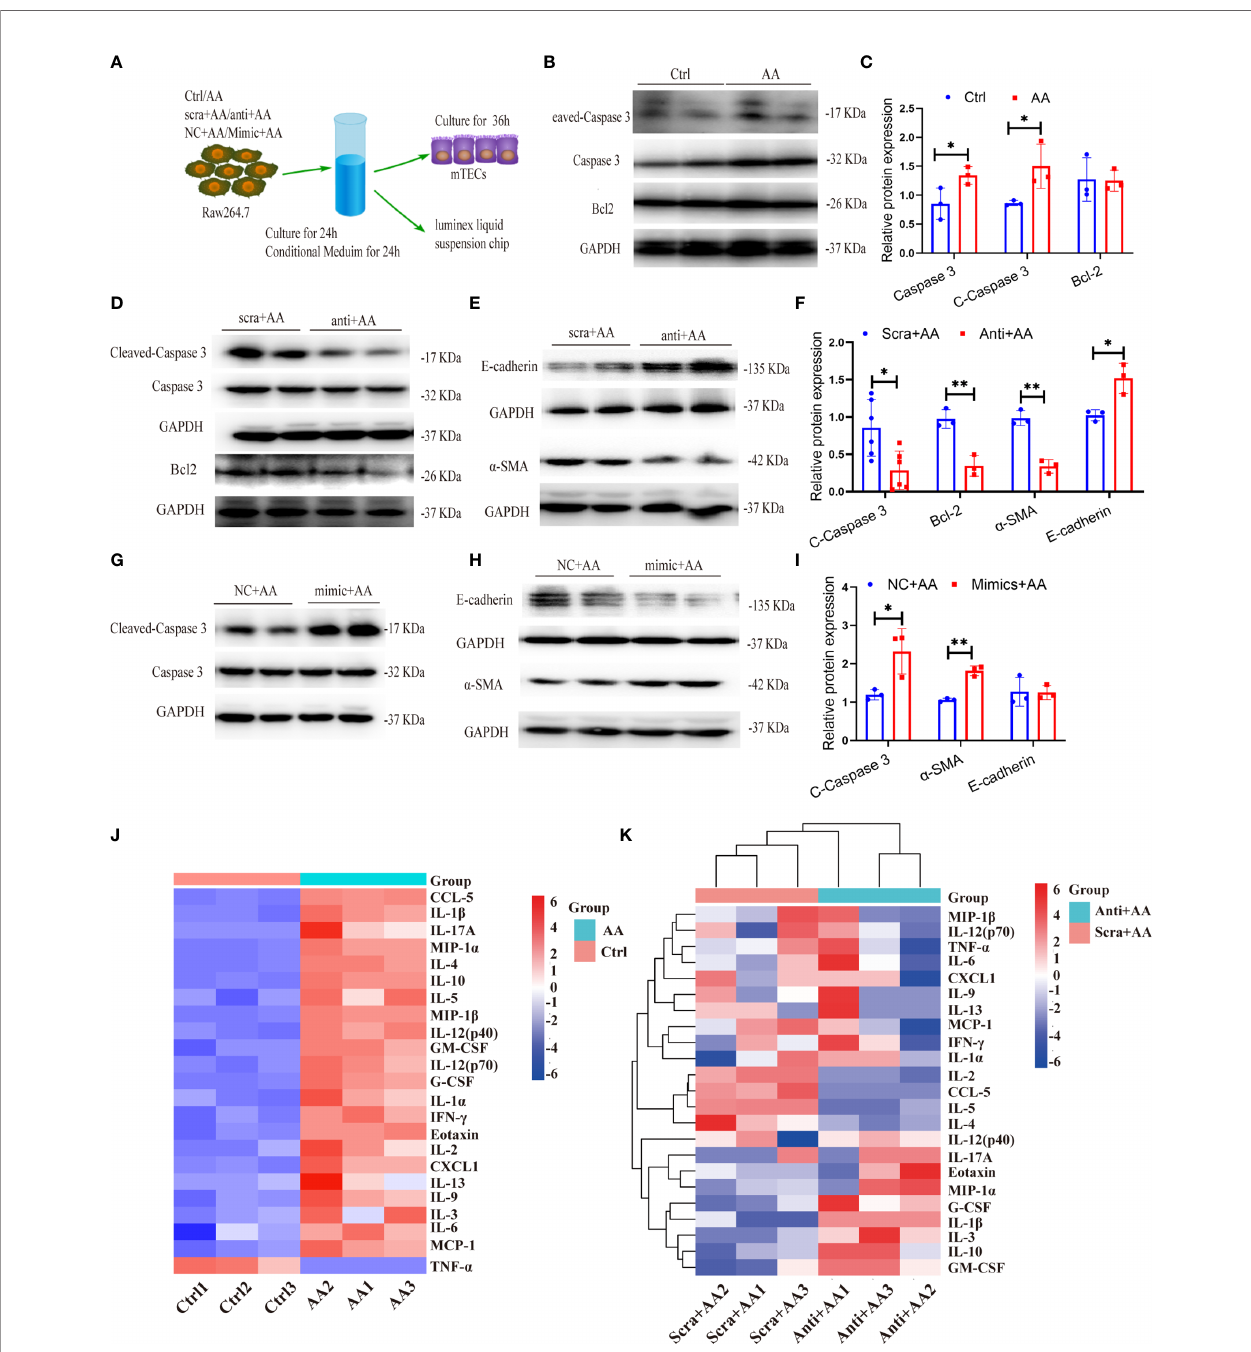
FIGURE 10 | miR-382 in macrophage promotes the apoptosis and epithelial – mesenchymal transition (EMT) in kidney tubular cells. (A) Schematic diagram showing the experimental setup of performing coculture between Raw264.7 and MTECs. (B, C) Representative Western blot and quanti fi cation of Cleaved Caspase 3, Caspase 3, and Bcl-2 in MTECs with treatment of supernatant for 48 h from Raw264.7 (Ctrl or AA group). GAPDH served as standard. (D – F) Representative Western blot and quanti fi cation of Cleaved Caspase 3, Caspase 3, and Bcl-2 as well as E-cadherin and a -SMA in MTECs with treatment of supernatant for 48h from Raw264.7 (anti-scramble+ AA or anti-miR-382+ AA group). GAPDH served as standard. (G – I) Representative Western blot and quanti fi cation of Cleaved Caspase 3 and Caspase 3 as well as E-cadherin and a -SMA in MTECs with treatment of supernatant for 48 h from Raw264.7 (NC+ AA or Mimic+ AA group). GAPDH served as standard. (J) Luminex liquid suspension chip analysis of conditional medium (CM) collected from Raw264.7 in ctrl and AA groups. (K) Luminex liquid suspension chip analysis of conditional medium (CM) collected from Raw264.7 in anti-scramble+ AA and anti-miR-382+ AA groups. * P < 0.05; ** P < 0.01;